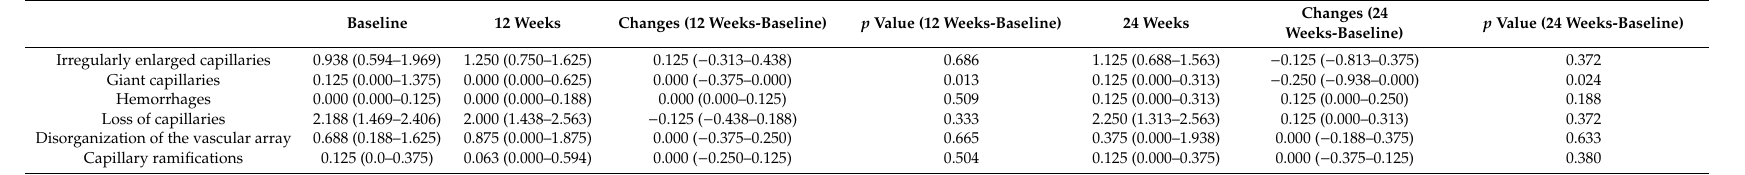
Table 6. Changes of nailfold capillary microscopic findings (12 weeks, 24 weeks).